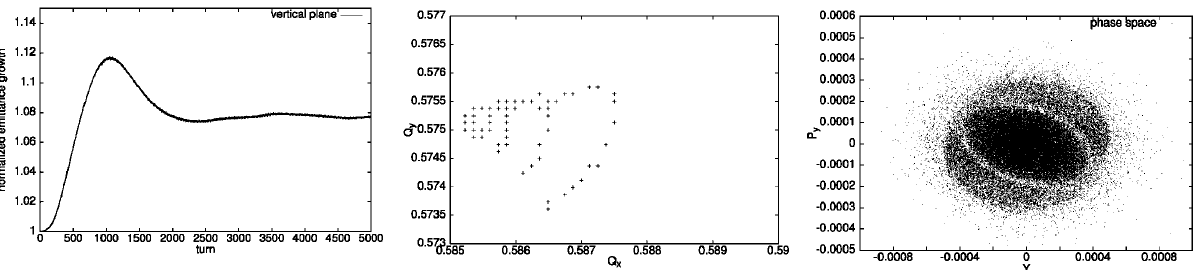
FIG. 3. The vertical normalized emittance growth of the weak beam (left panel), the tune spread of the weak beam with initial maximum 5 (cid:22) amplitude range (middle panel), and the vertical phase space distribution after 1500 turns (right panel), with an initial 20% mismatch of the strong beam and 2 (cid:22) vertical offset